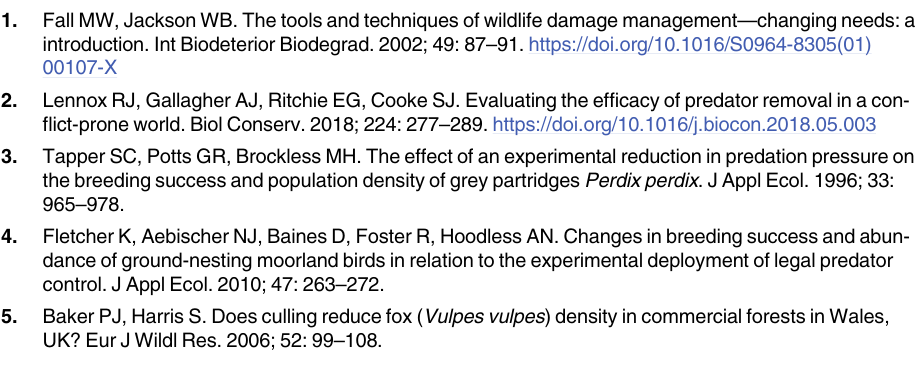
S1 Table. Estate area, number of contributed weeks’ data, number of weeks of lamping effort and lamping effort per km 2 in each